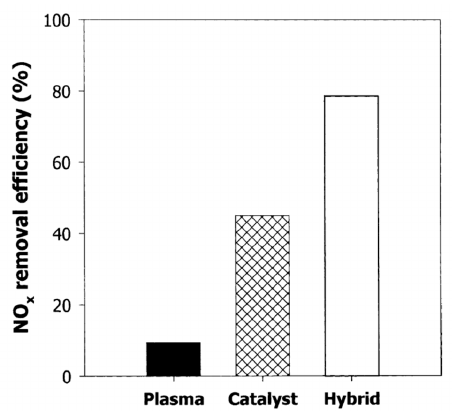
Figure 13. Comparison of NO x removal efficiencies between hybrid plasma-catalyst with each stage at 150 ℃ and ED of 25 J/L. Reprinted from Reference [96], with permission Springer Nature. Simultaneous removal of NO x , HC, and PM from an actual DEG in a DBD was in- vestigated by Song et al. [97] in 2009; the plasma discharge was driven by an AC high voltage with a peak voltage of 0–14 kV along with a frequency of 10–27 kHz. The authors examined several key factors of plasma discharge on the contaminant removals, namely peak voltage, frequency, and gas component by adjusting engine load. When maintained frequency at 15.5 kHz, a high-peak voltage to the level off-peak voltage led to an increase in the removal efficiency of HC and PM; whereas, the efficiency of NO started to decrease when the peak voltage was above 8 kV ( ≥ 240 J/L). At peak voltage of 8 kV, the efficiency of contaminant removal increased with the frequency from 12.5 to 15.5 kHz; afterward, an increase in frequency led to a decrease in the removal efficiencies. The system exhib- ited the highest PM, HC, and NO x removal efficiencies of 80%, 75%, and 65%, respec- tively; additionally, removal of SOF seems to be accessible than polycyclic aromatic hy- drocarbons in the plasma discharge.